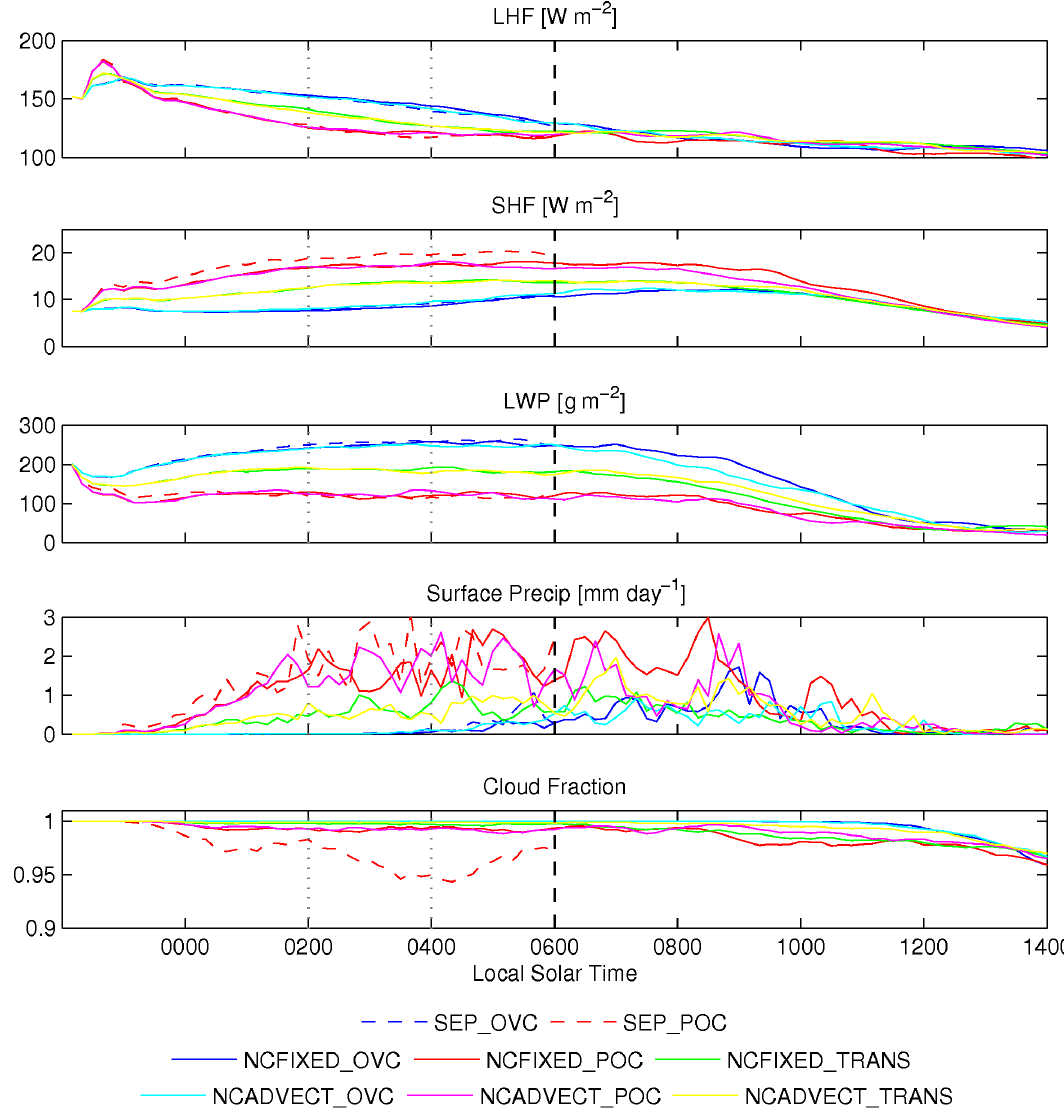
Fig. 7. Region averaged time series of key quantities for all model runs. Sunrise is at 06:00 LST (vertical dashed line). liquid water despite being very thin; the fixed N c across the POC does not allow for this behavior in the